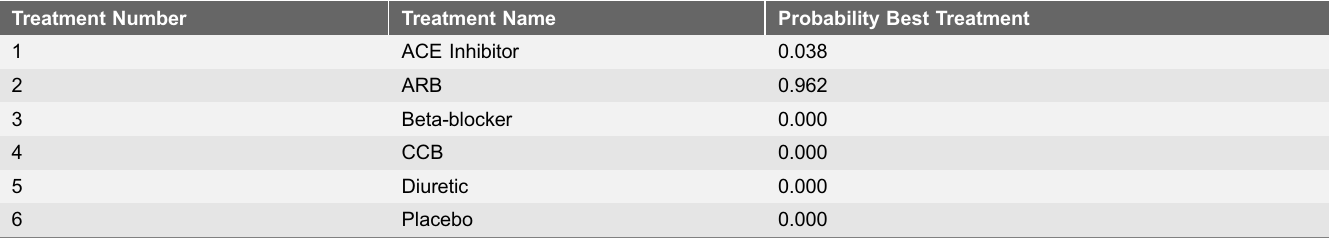
Table 8. Estimated 1 st rank probabilities of treatments from the Diabetes dataset obtained from the pcnetmeta package. Treatment